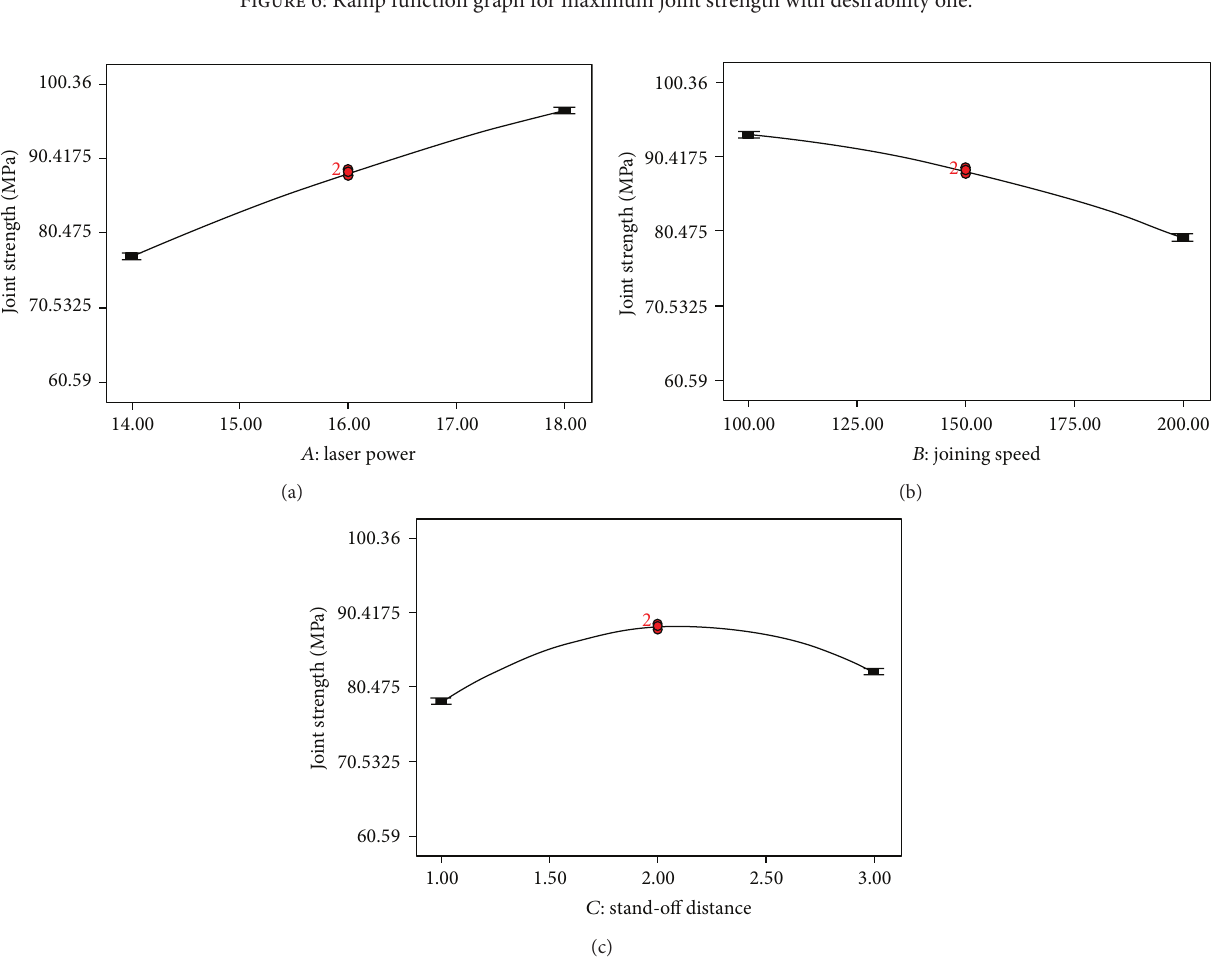
and stand-off distance were 17.99 watt, 102.28 mm/min,